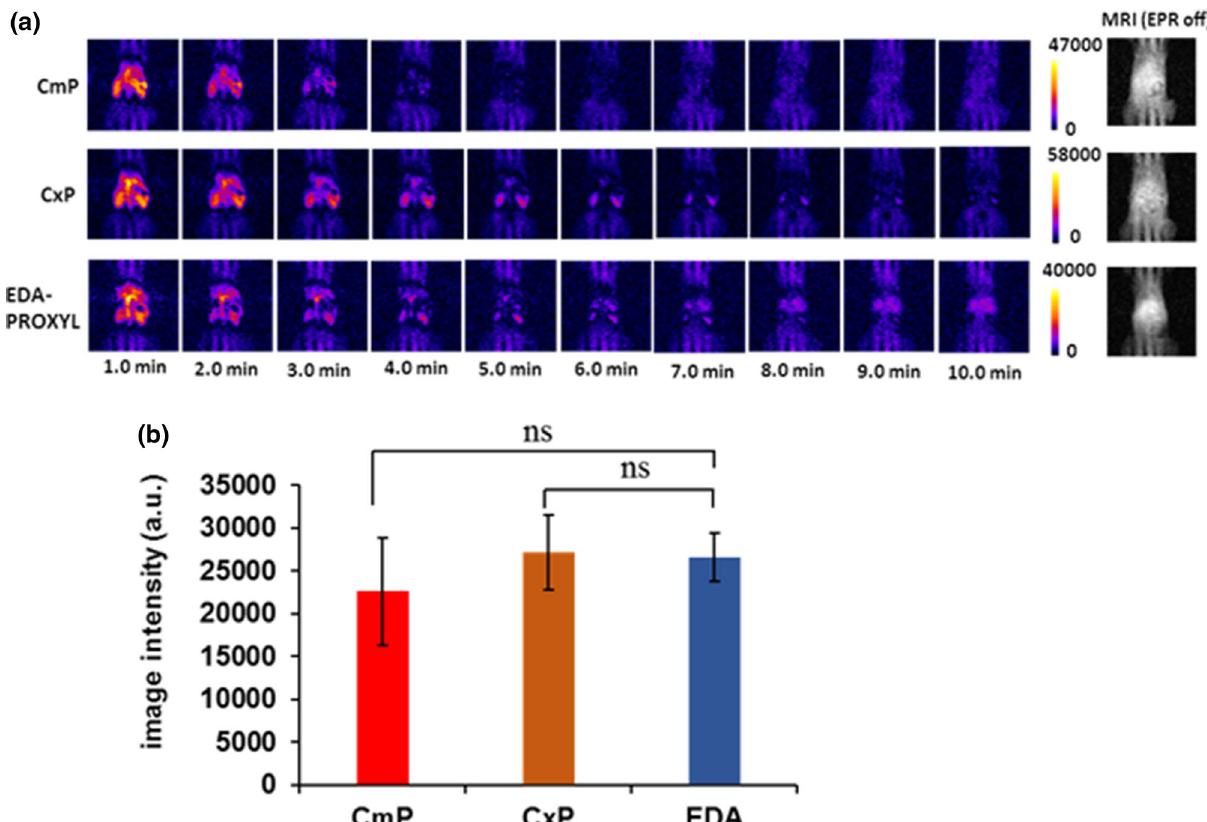
Figure 5. ( a ) In vivo kinetic dynamic nuclear polarization-magnetic resonance images of the upper abdomen regions of mice after intravenous injection of carbamoyl PROXYL, carboxyl PROXYL, or EDA-PROXYL. The in vivo DNP-MRI data were analysed using Image J software 51 (n = 5 per group), ( b ) Image intensity 1 min after intravenous injection of each probe. Data are presented as mean ± standard deviation (n = 5 per